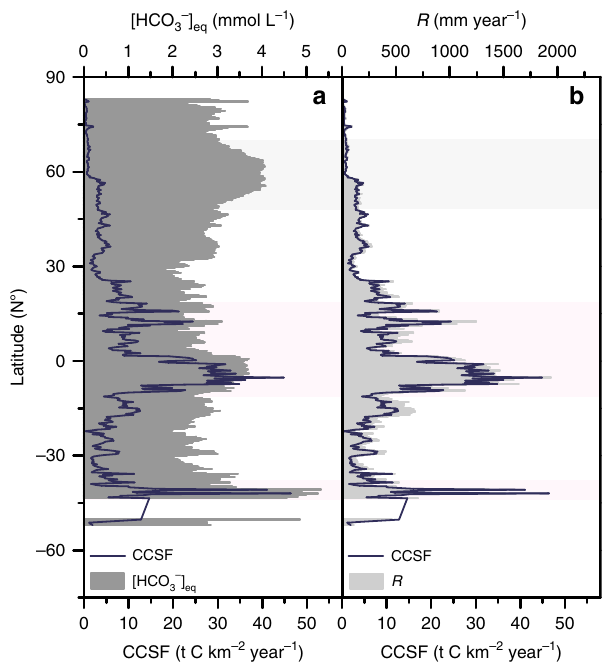
Fig. 5 Latitudinal CCSF variation with relevant variables. CCSF (carbonate weathering carbon-sink fl ux, blue line in a and b ) in relation to a [HCO 3 − ] eq (dark grey-shaded area) and b R (runoff, light-gray shaded area) in the historical period (1950 – 2005). CCSF shows a signi fi cant positive relationship to runoff ( R ) across all